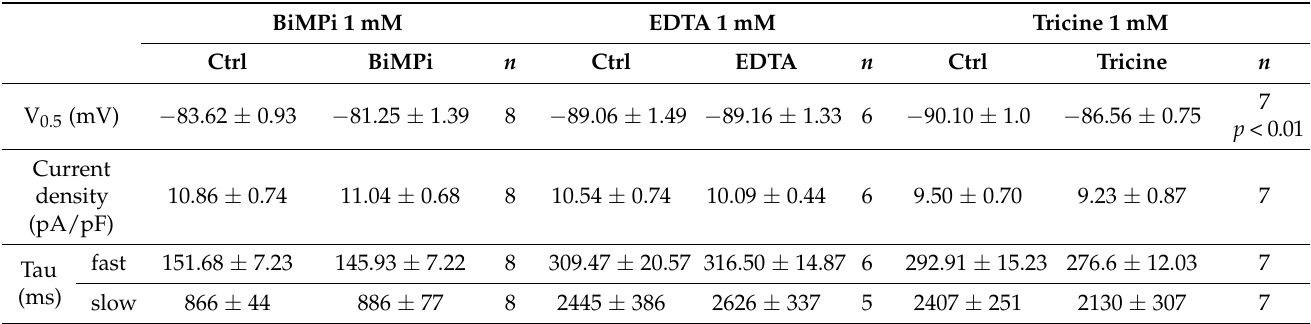
Table 1. The effects of divalent cation chelators on I h current in TC neurons. Data are given as mean ± SEM. The control measurement and corresponding substance effect were recorded from the same cell. BiMPi 1 mM EDTA 1 mM